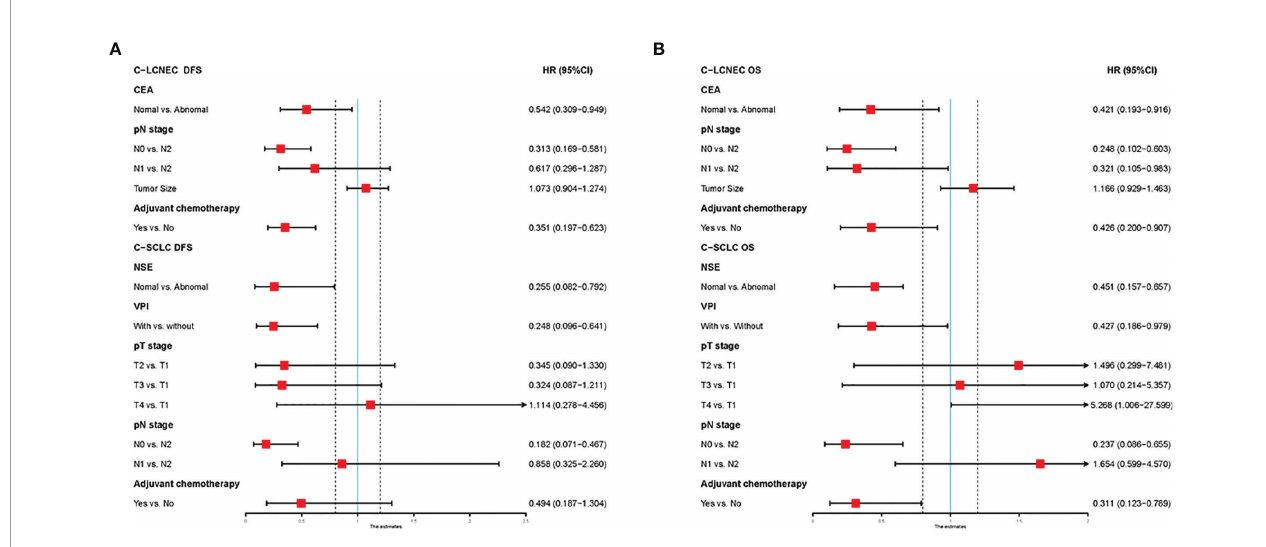
FIGURE 3 | Multivariate Cox regression analysis on clinical characteristics for DFS (A) and OS (B)